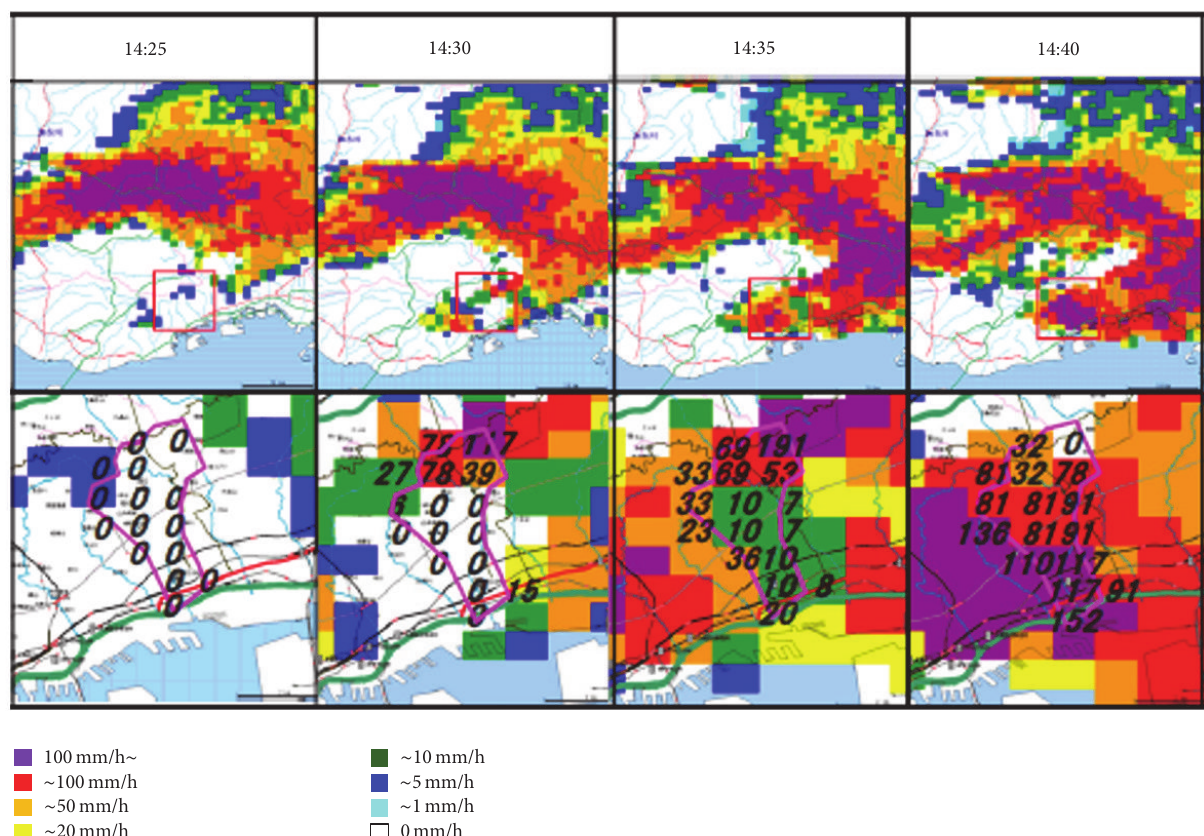
Figure 2: Rainfall intensity from low angle observation by C-band radars operated by the MLIT. Lower figures show zoom-in distributions in the range of the red rectangular in upper figures. The numbers in lower figures mean the radar estimated value of rainfall